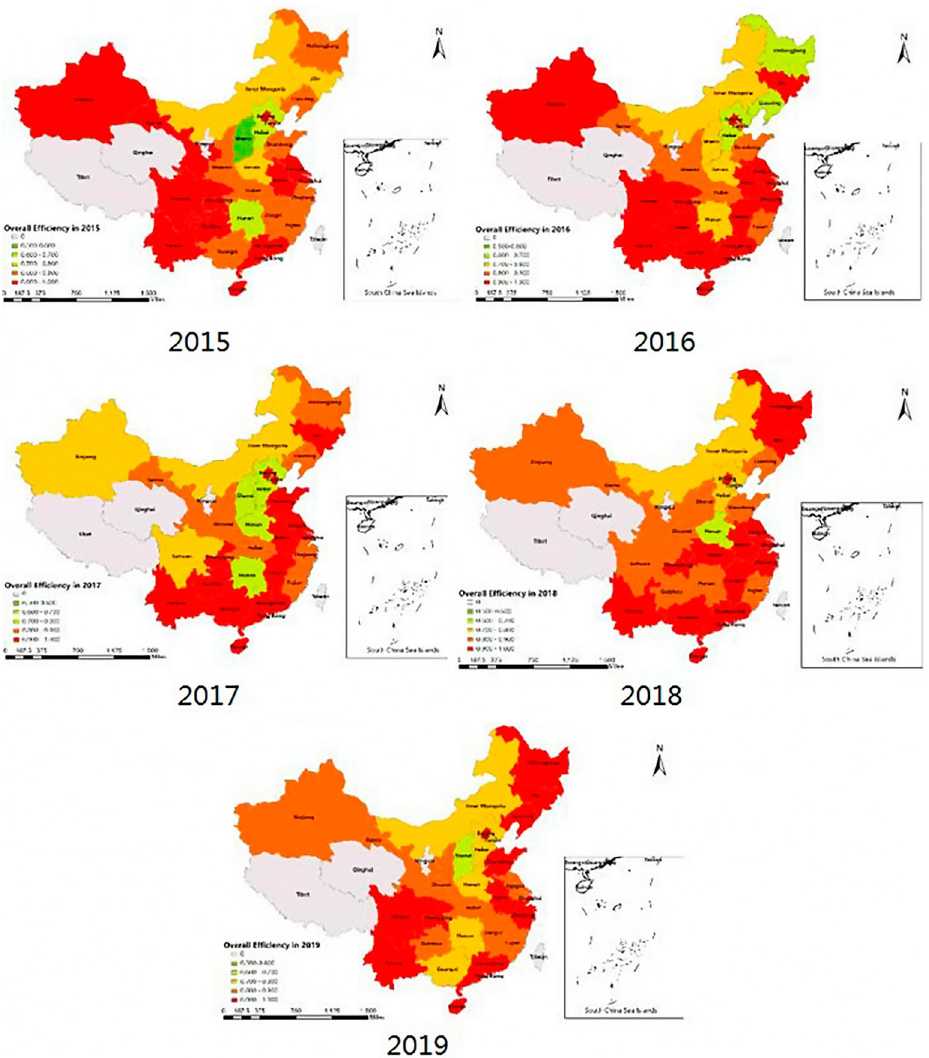
Figure 3. Temporal and spatial distributions of the total efficiency of China’s provinces from 2015 to 2019